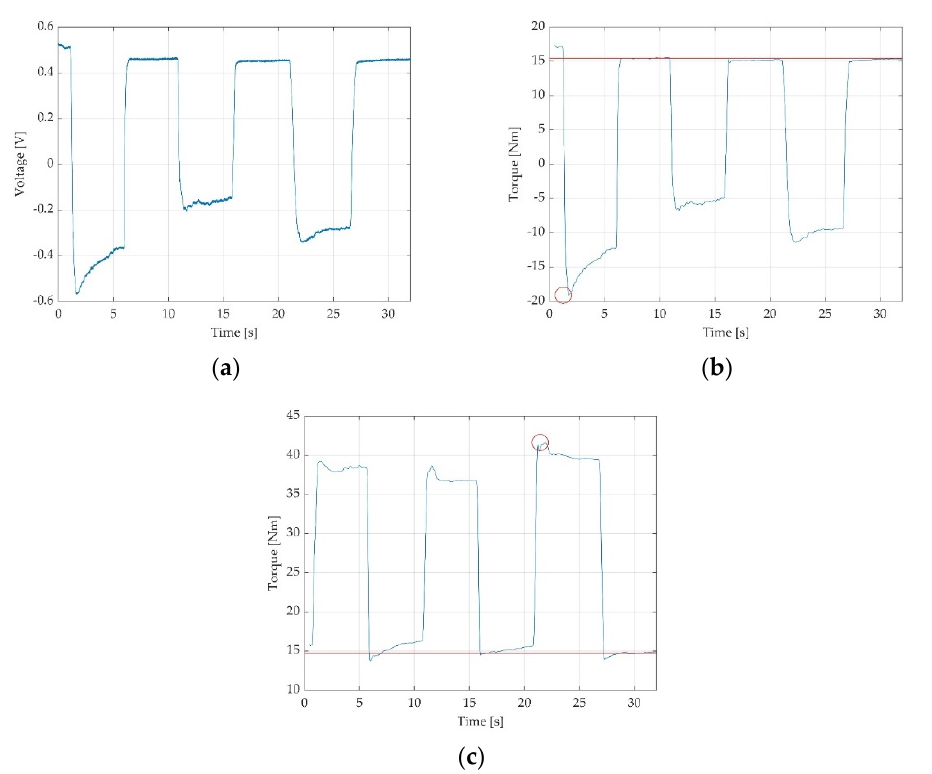
Figure 4. Three time-graphs of recordings, representing three MVIC of 5 s each followed by 5 s of relaxation between contractions: ( a ) resulted time graph of voltage in V during ankle dorsiflexion; ( b ) the same ankle dorsiflexion measurement represented as torque in Nm; ( c ) another example of valid time graph during ankle plantarflexion, representing torque in Nm.